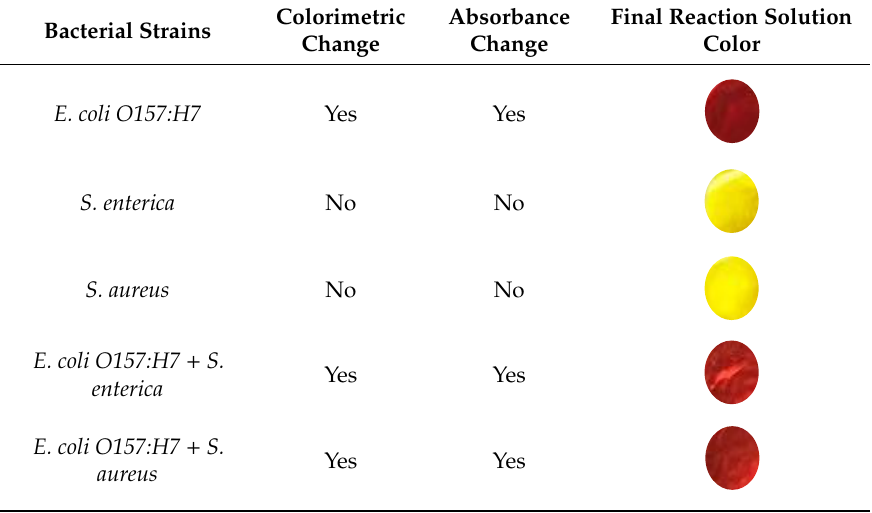
Table 1. Specific colorimetric response on target E. coli O157:H7 after immunomagnetic separation and enzymatic reaction. Salmonella enterica ( S. enterica ) and Staphylococcus aureus ( S. aureus ) were used as non-target bacteria strains (10 4 CFU/mL in milk samples).